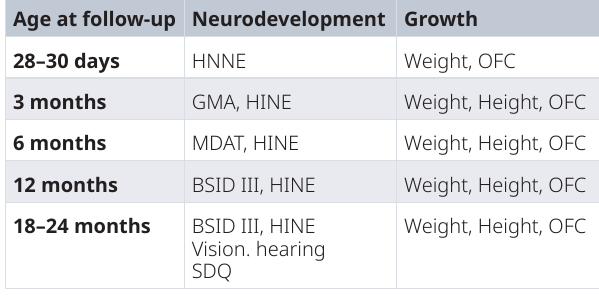
assessments between 28 days to 24 months of